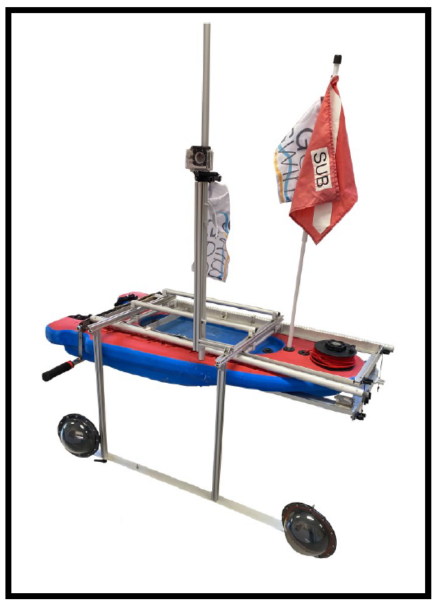
Remote Sens. 2020 , 12 , 1880 Figure 3. Lateral view of the raft with the support console. Figure 3. Lateral view of the raft with the support console.